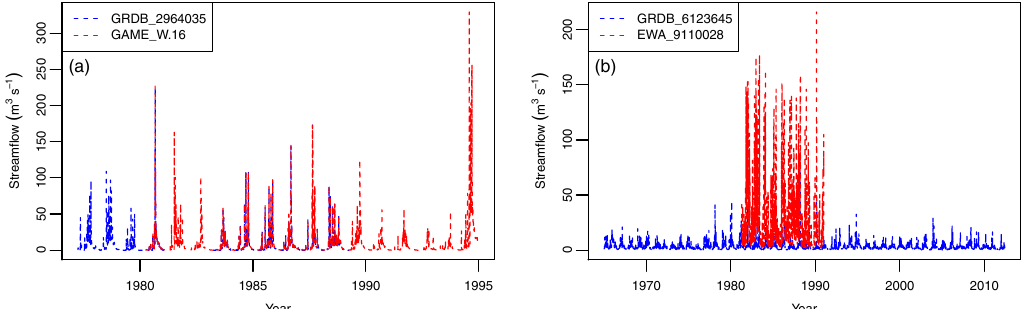
Figure 2. Examples of visually inspected duplication-candidate time series. (a) Two stations that were labelled “very likely identical” stations. (b) Two stations that were labelled “very likely different”